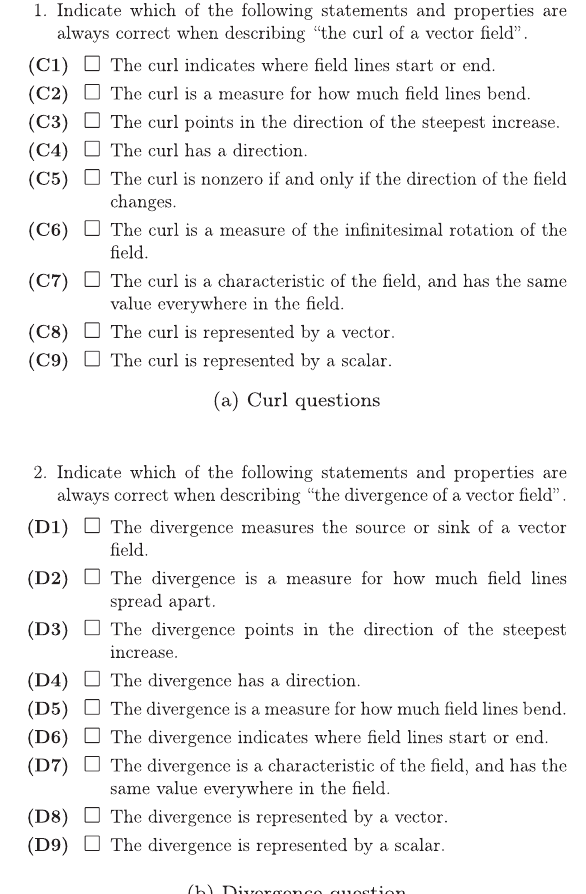
FIG. 5. Questions designed to assess students ’ correct and incorrect conceptions of curl and divergence. The correct state- ments are C4, C6, C8, D1, D6, and